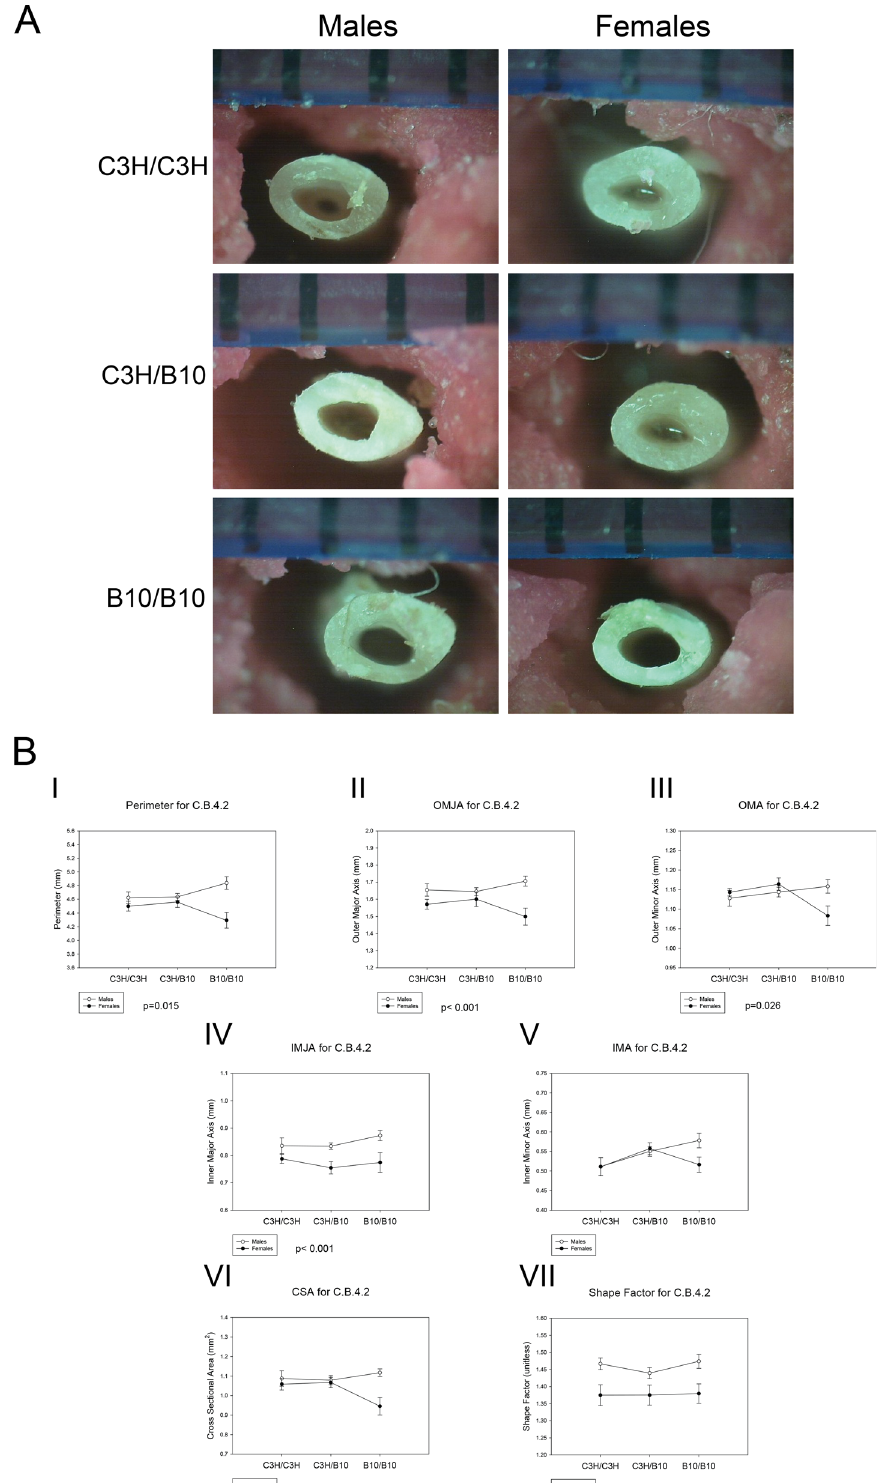
Fig 3. Femoral Geometry of C.B.4.2 mice. (A) Representative photographs of C.B.4.2 femur cross sections following 3-point bending test for each genotype. (B) The effects of sex and genotype on (I) perimeter, p = 0.015, sex by genotype interactions B10/B10 females < B10/B10 males; (II) OMJA, p < 0.001, sex